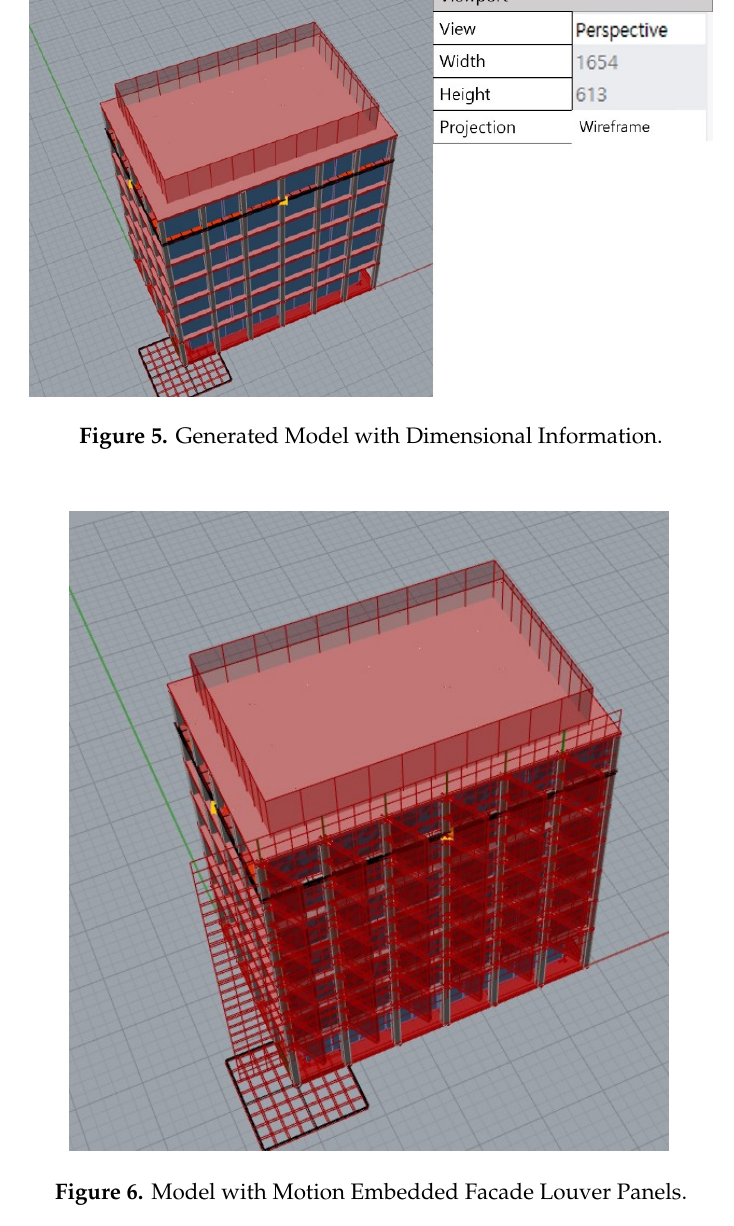
Figure 5. Generated Model with Dimensional Information.